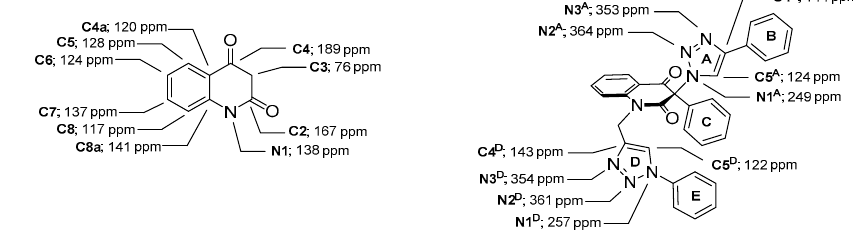
Figure 2. Selected ring and atom numbering along with the chemical shift data (mean values rounded up to whole numbers are provided).